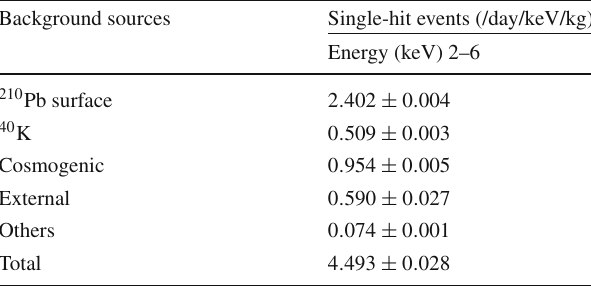
Table 5 Simulated background events of NaI-005 in dru unit (/day/keV/kg) in the (2–6) keV energy interval